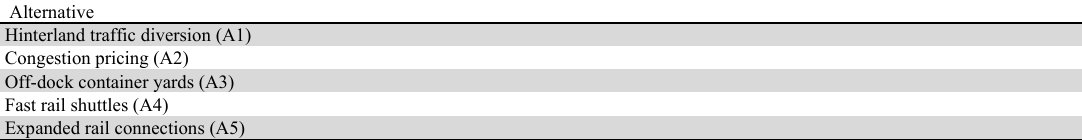
Alternatives for the evaluation process Alternative Hinterland traffic diversion (A1)